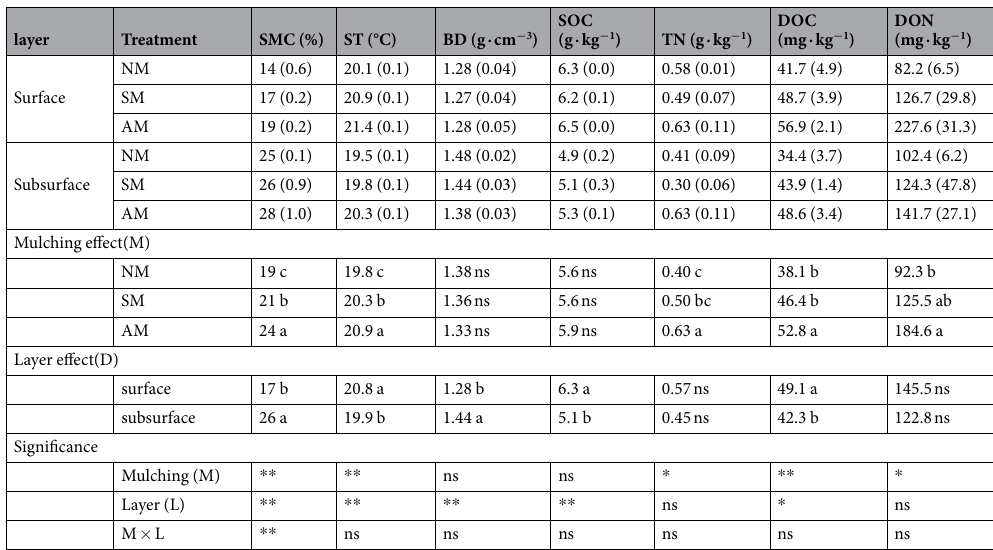
Table 1. Effects of different mulching treatments on the physical and chemical properties of the soils sampled at two layers. Values are means (with standard error in parentheses). The values in mulching effect or layer effect were given the mean under each mulching treatment or soil layer. SMC: soil moisture content; ST: soil temperature; BD: bulk density; SOC: soil organic carbon; TN, total nitrogen; DOC, dissolved organic carbon; DON: dissolved organic nitrogen; Values within columns followed by the same letter do not differ at < 0.05. ns: not significant. * Significant at 0.05 level. ** Significant at 0.01